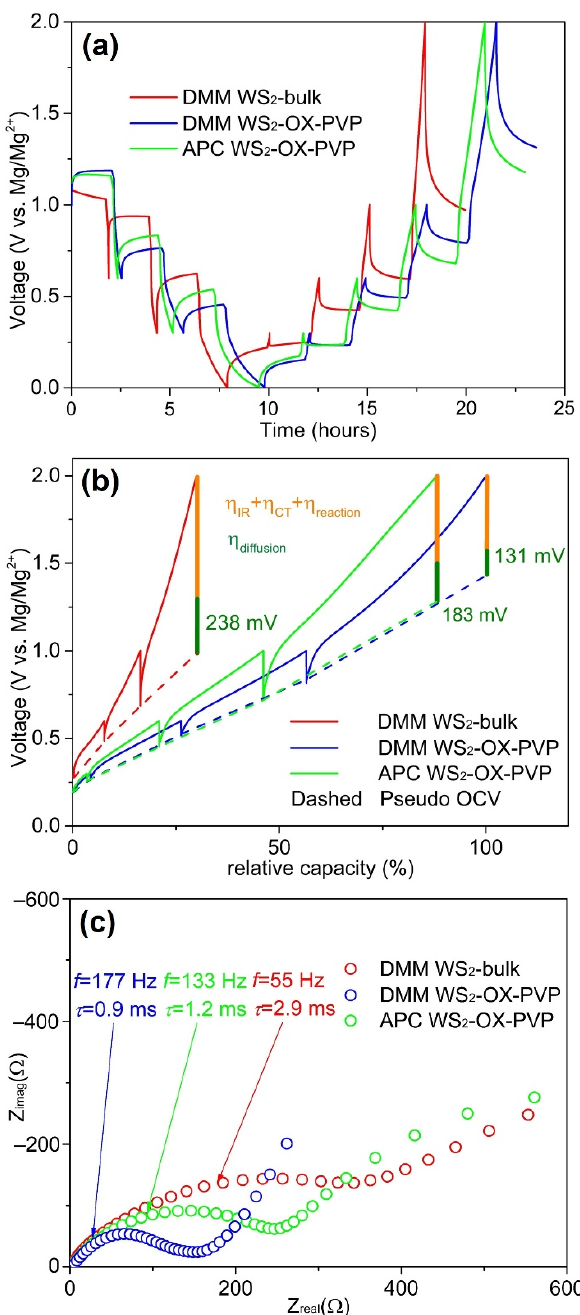
Figure 6. ( a ) Pulsed discharge–charge cycle with 2 h of relaxation at several cell potentials. The circles mark conducted impedance measurements, red circles: measurements discussed here. ( b ) The same cyle plotted vs. specific capacity. The connected end potentials of the relaxation steps approximate the pseudo OCV curves (dashed lines). ( c ) Impedance spectra of WS 2 -bulk DMM (red), WS 2 -OX-PVP DMM (blue), and WS 2 -OX-PVP APC (green) after pausing discharge at 0.3 V for 2 h.